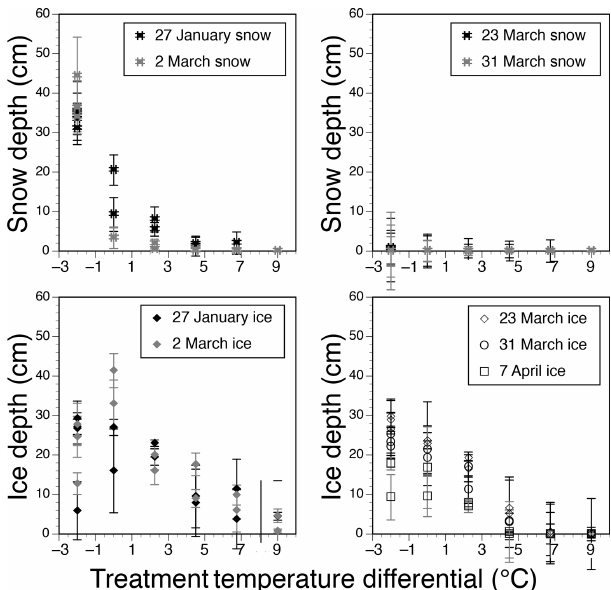
Figure 14. Snow depth (upper graphs) and ice depth (lower graphs) in each plot on 27 January and 2, 23, 31 March and 7 April 2016. All values are the mean depth ± sd for four locations within replicate plots represented by the target treatment temperature differentials.